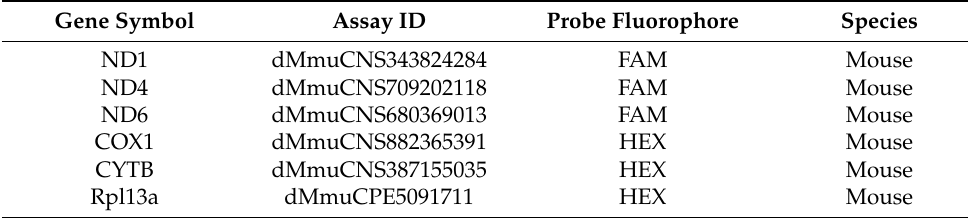
Table 1. Mitochondria Encoded Mitochondrial Gene